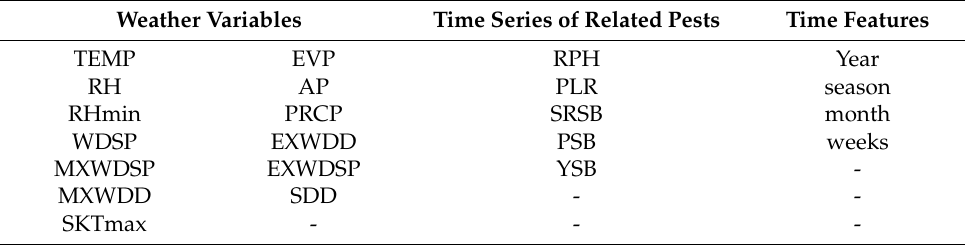
Table 4. Rice pests, weather, and time datasets.